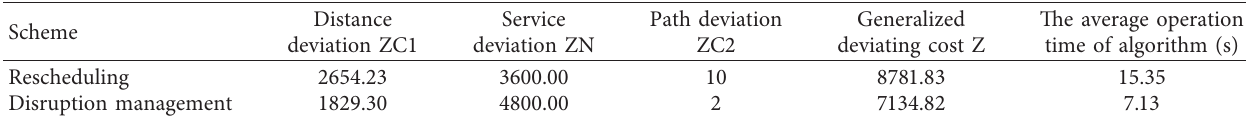
Figure 5: Two-stage algorithm results in MATLAB. (a) Initial path. (b) Decision-making period 1. (c) Decision-making period 2. (d) Decision-making period 3. Table 1: Comparison of optimization results and rescheduling scheme.